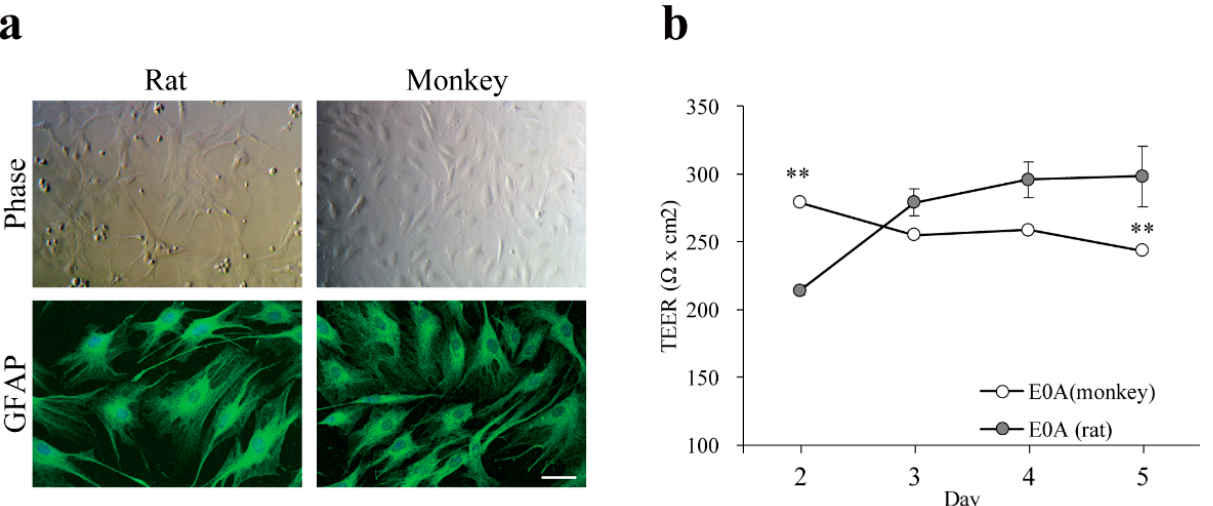
Figure 3. ( a ) Characterization of primary monkey astrocytes by immunofluorescence microscopy. Both monkey and rat astrocytes express glial fibrillary acidic protein (GFAP). Cell nuclei were counterstained with TO-PRO-3 (blue). Bar = 50 µ m; ( b ) Barrier function of the co-culture BBB models with astrocytes. BECs from monkey were co-cultured with astrocytes from either monkey (E0A (monkey)) or rat (E0A (rat)). Barrier function was assessed by measuring TEER. Values presented are means ± SEM. (n = 3, ** p < 0.01). E00: monkey brain endothelial monolayers; E0A: co-culture of monkey brain endothelial cells and astrocytes (rat or monkey).